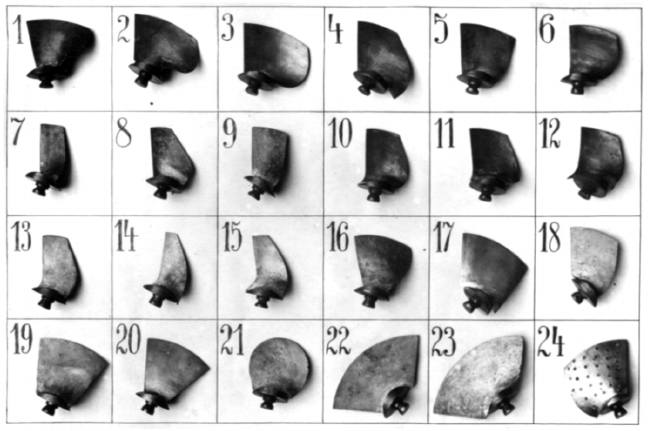
Figure 7. Experimental rotatable impeller blades. Source: [5].